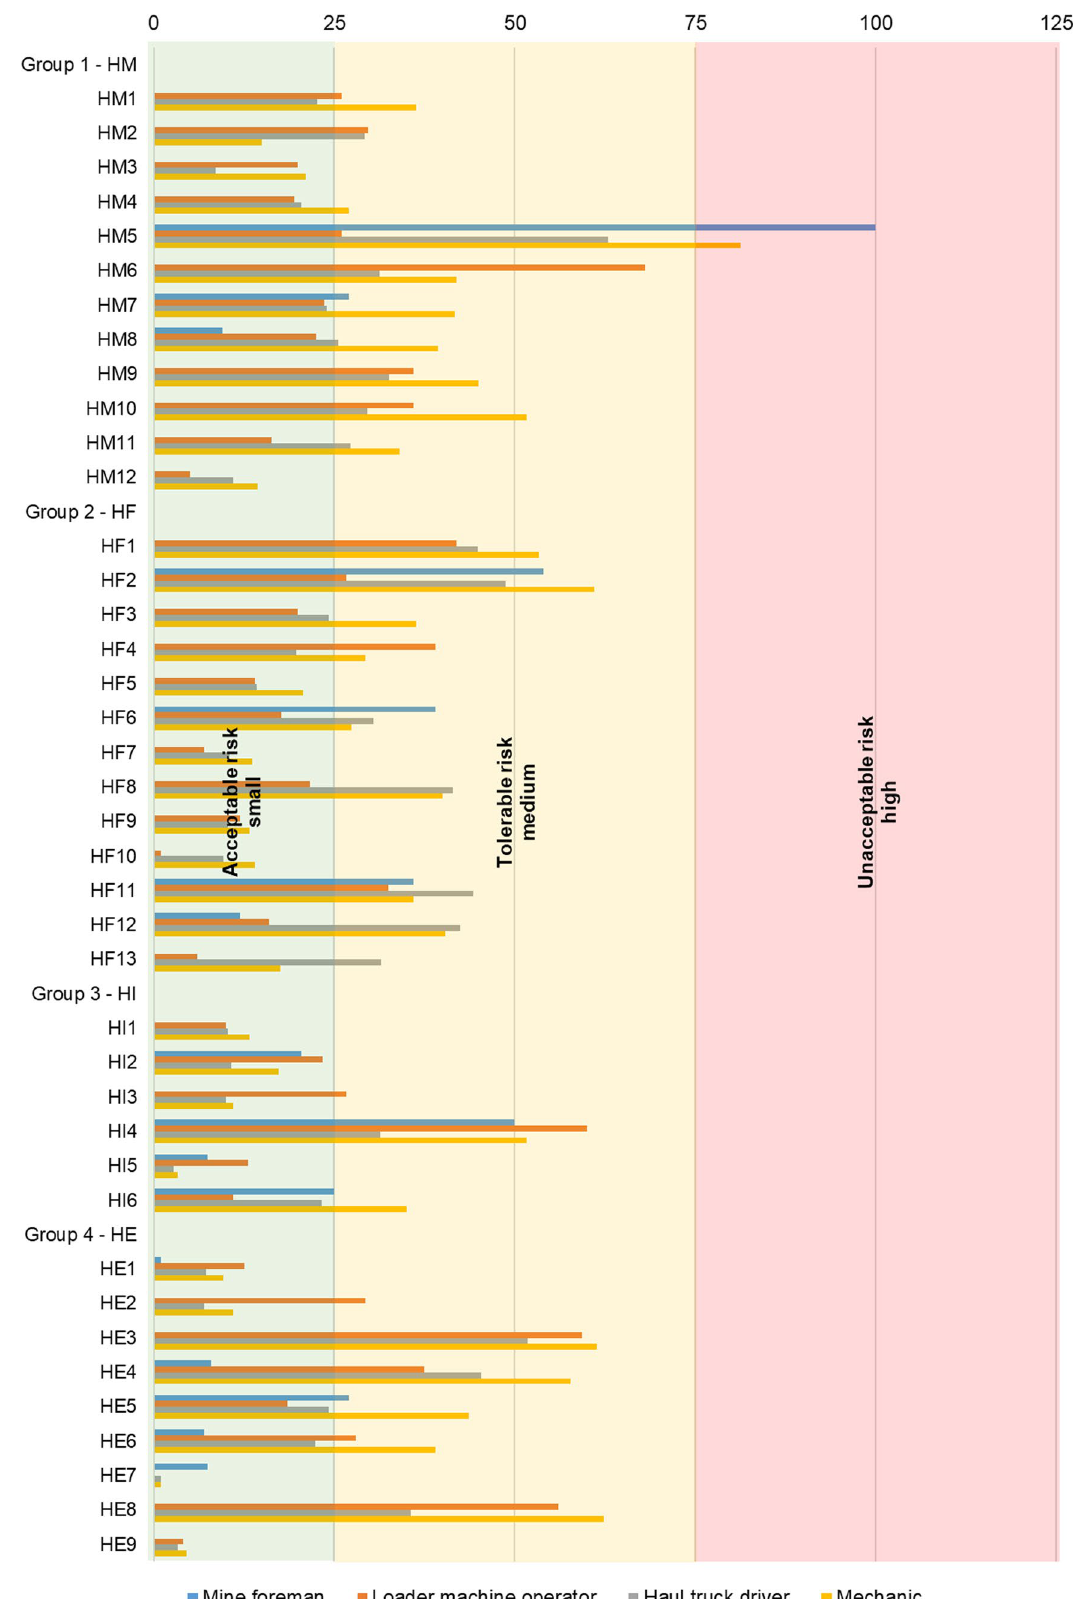
Fig. 6 Size of the occupational risk at the job